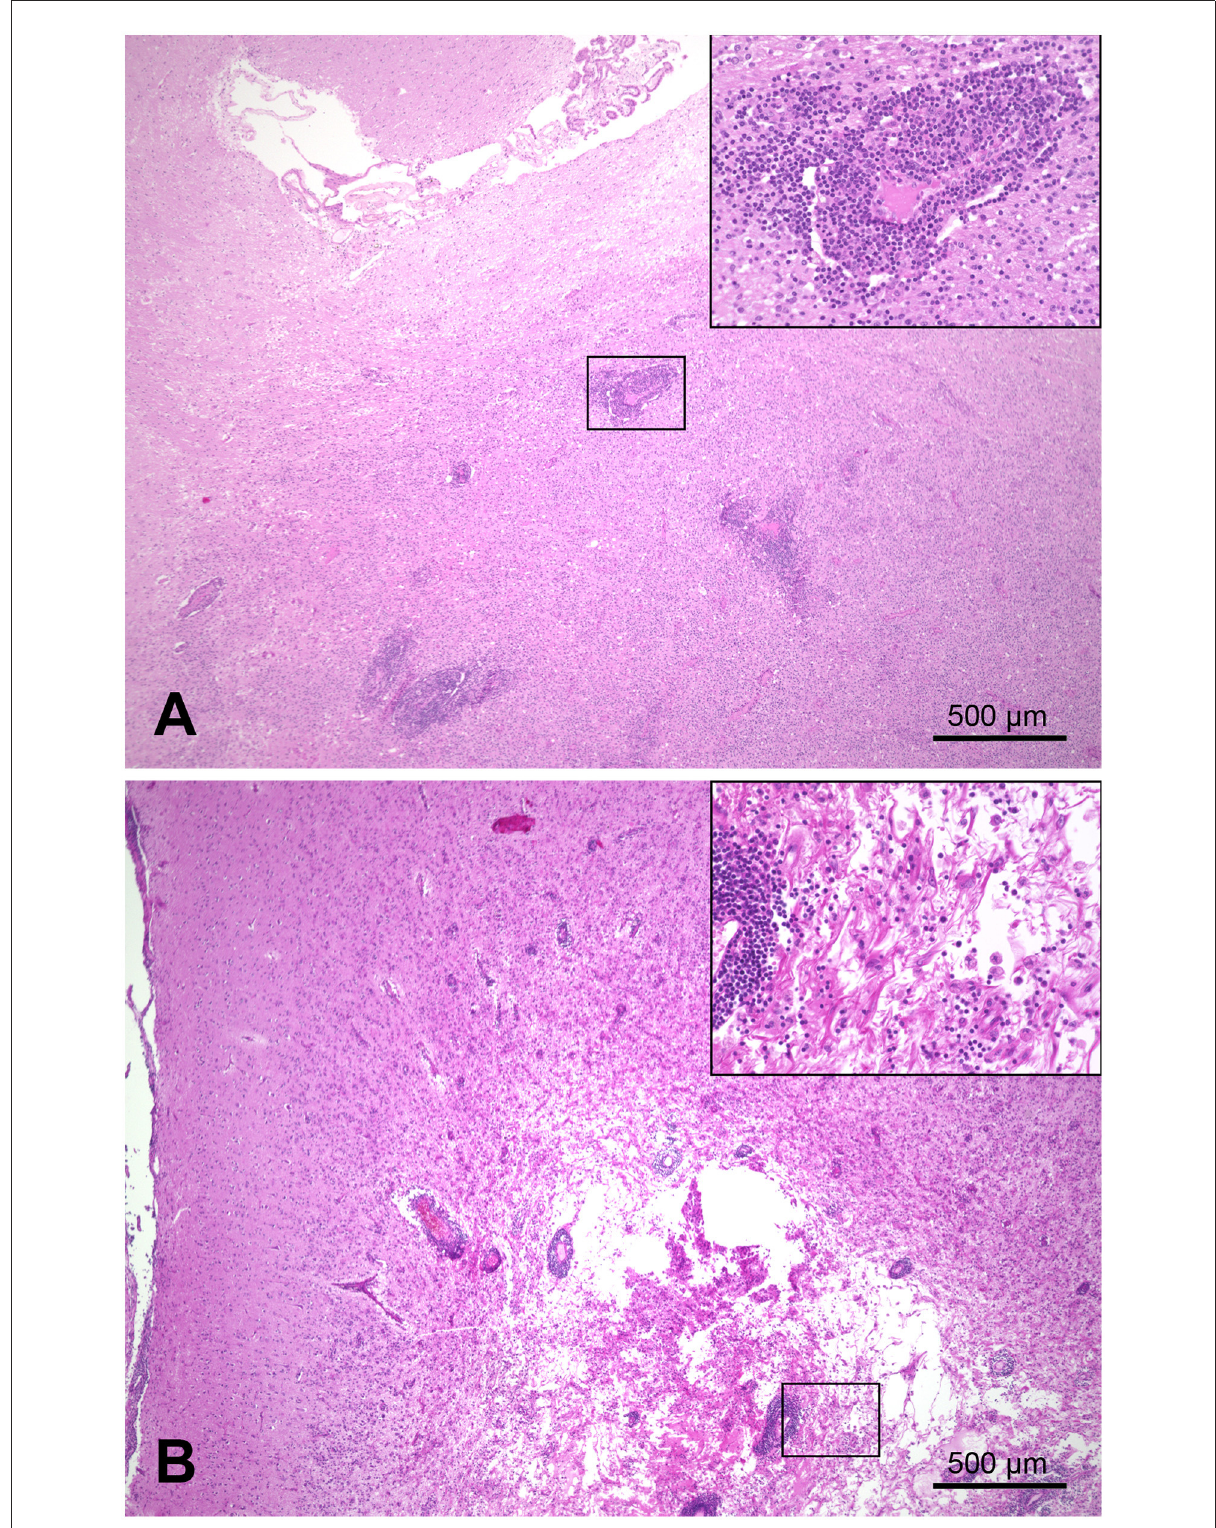
FIGURE2 Combined necrotizing leukoencephalitis and granulomatous meningoencephalitis in the brain of a Yorkshire Terrier (case 1). (A) right striatal body; marked granulomatous inflammation with severe lymphocytic perivascular cuffing. (B) cerebrum, left parietal lobe; marked necrotizing leukoencephalitis in subcortical white matter with gitter cells (malacia) and severe lymphohistiocytic perivascular cuffing; bars = 500 µ